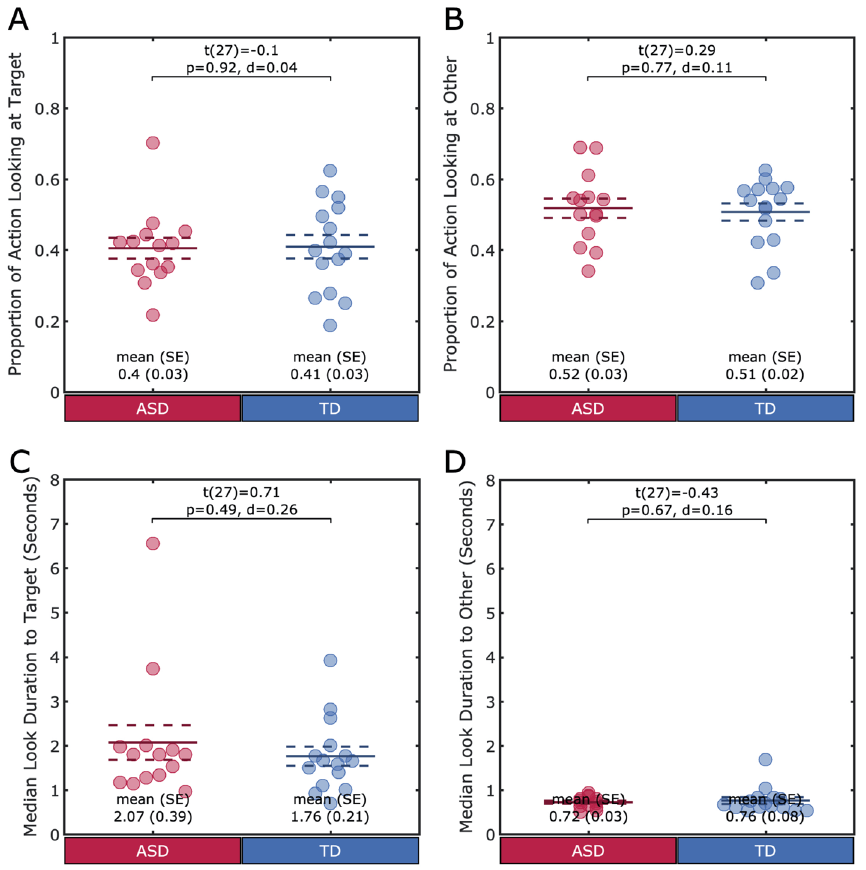
Figure 4. Hand-Eye Coordination. ( A – D ) Each individual is represented by a circle. The group mean is represented by the solid line, and the standard error is represented by the dotted lines. ( A ) Groups did not differ in the proportion of time acting upon a toy that they spent looking to the target toy ( B ) or to another toy. ( C ) Groups also did not differ in the duration of looks to the acted upon toy (D) or to the duration of looks to a non- in-hand toy while acting on a different